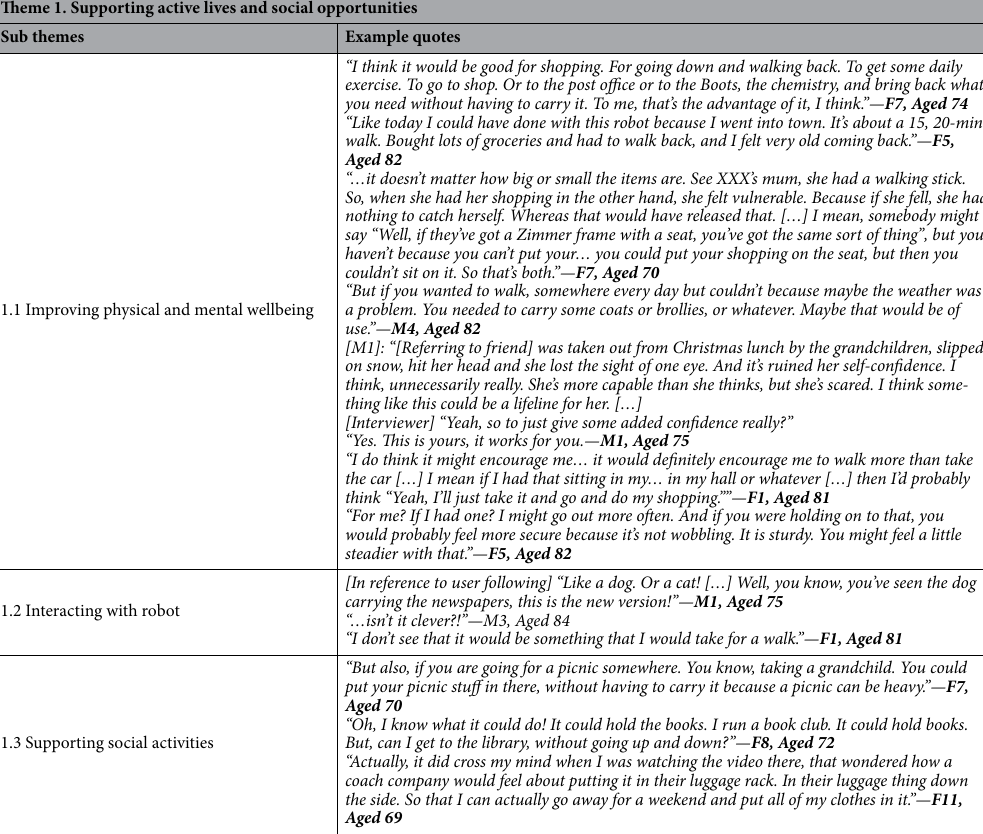
Table 2. Example quotes of Theme 1 Supporting active lives and social opportunities.